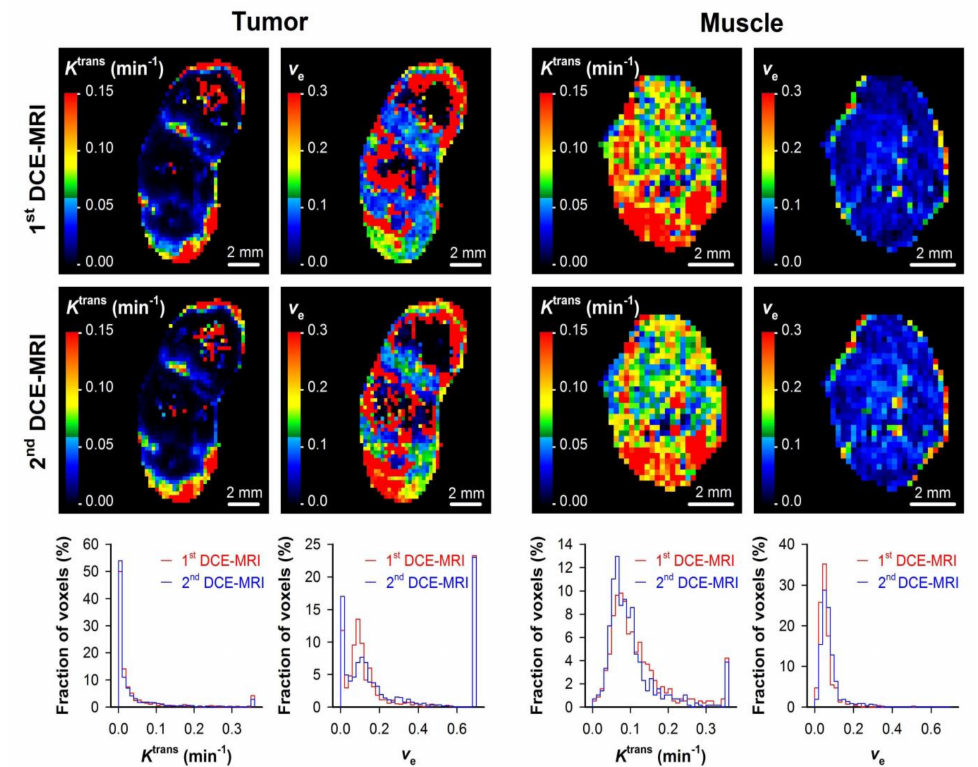
Figure 1. The reproducibility of the dynamic contrast-enhanced magnetic resonance imaging (DCE-MRI) acquisition and analysis was investigated by subjecting tumors and normal muscle tissue to DCE-MRI twice, with an imaging interval of 60 min. The figure shows the transfer rate constant ( K trans ) images, K trans frequency distributions, extravascular extracellular volume fraction ( v e ) images, and v e frequency distributions derived from the first and the second DCE-MRI session of a tumor and a tumor-free leg muscle and illustrates that highly reproducible data was obtained. Modified from Wegner et al. [24].